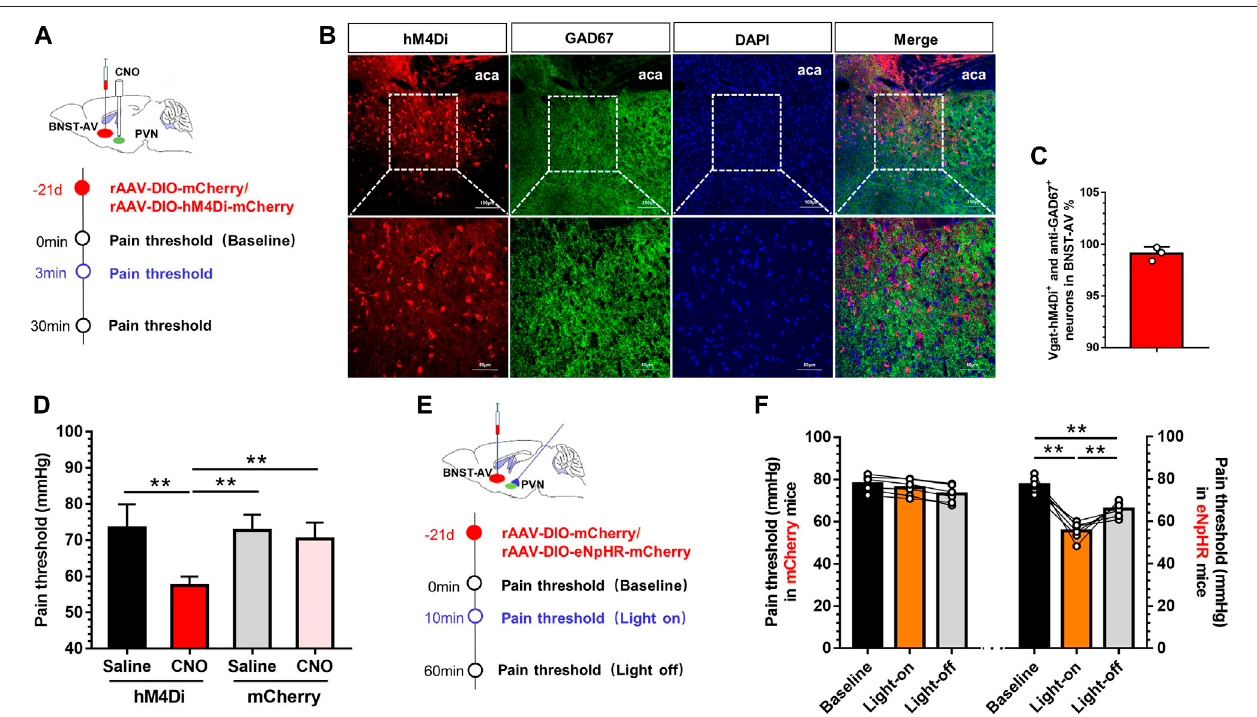
FIGURE 5| Inhibition of GABAergic BNST AV -PVN neurons induced the visceral pain in normal Vgat-Cre mice (A) Schematic diagram of AAV-DIO-hM4Di-mCherry injection into the BNST-AV and trocar implantation into the PVN in Vgat-Cre mice (B) The Vgat-hM4Di-mCherry neurons were stained with antibody to GAD67 to verify effects of virus-labeled GABAergic neurons in the BNST-AV (C) The co-standard rate of labeled GABAergic neurons and anti-GAD67 protein were 99.1% (D) The visceral pain threshold was signi fi cantly decreased post-CNO PVN injection ( n (cid:2) 6, ** p < 0.01) (E) Schematic diagram of AAV-DIO-eNpHR-mCherry injection into the BNST-AV and fi ber-opticincannulation intothePVN inVgat-Cre mice (F) Thevisceralpainthreshold wassigni fi cantlydecreasedafter photoactivationofthe terminal of PVN-projecting eNpHR-mCherry-positive neurons from BNST-AV area ( n (cid:2) 6, ** p < 0.01).